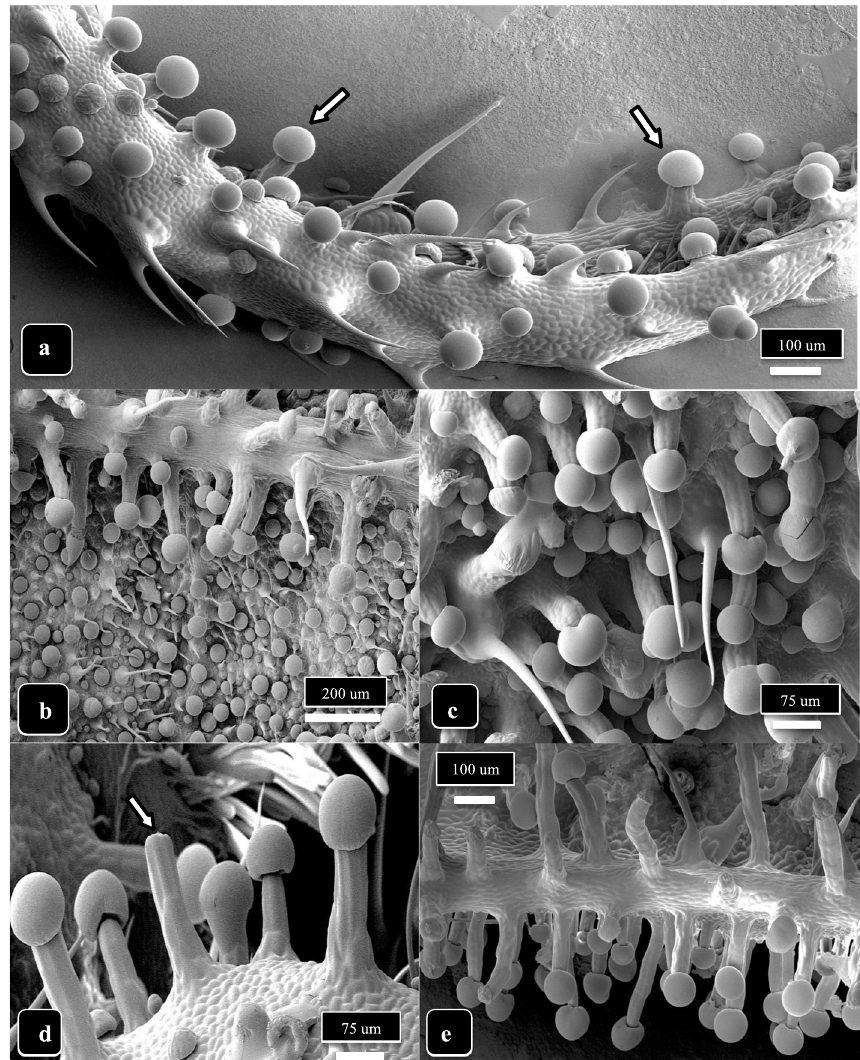
Fig. 3 Capitate trichome development on cannabis strain MD, lower bract surface, at 3 and 6 weeks of inflorescence development. a At 3 weeks, most capitate trichomes at the tip of the bract are sessile but a few (arrows) have started to develop stalks. Nonglandular hairs can be seen. b Stalked-capitate trichomes forming first along the midvein of a bract; abundant sessile-capitate trichomes can be seen in the background together with nonglandular hairs. c At 6 weeks, stalked-capitate trichomes can be seen densely packed together. d A range of stalk lengths can be seen, with one trichome stalk on which the head has been detached (arrow). e A view of the edge of a bract at 6 weeks of inflorescence development, showing greater abundance of stalked-capitate trichomes on the lower compared to upper bract surface. Trichome stalk lengths